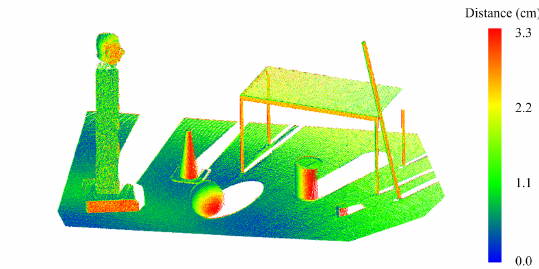
Figure 14: Distances between the scans after coarse registration